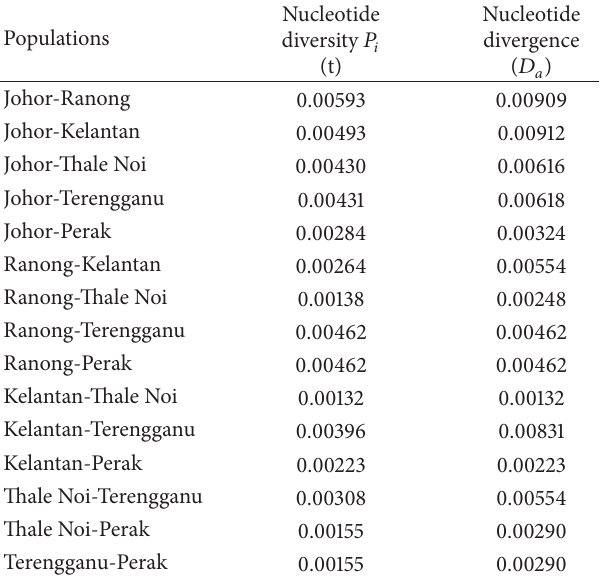
Table 2: Nucleotide diversity 𝑃 𝑖 (t) and nucleotide divergence ( 𝐷 𝑎 ) between